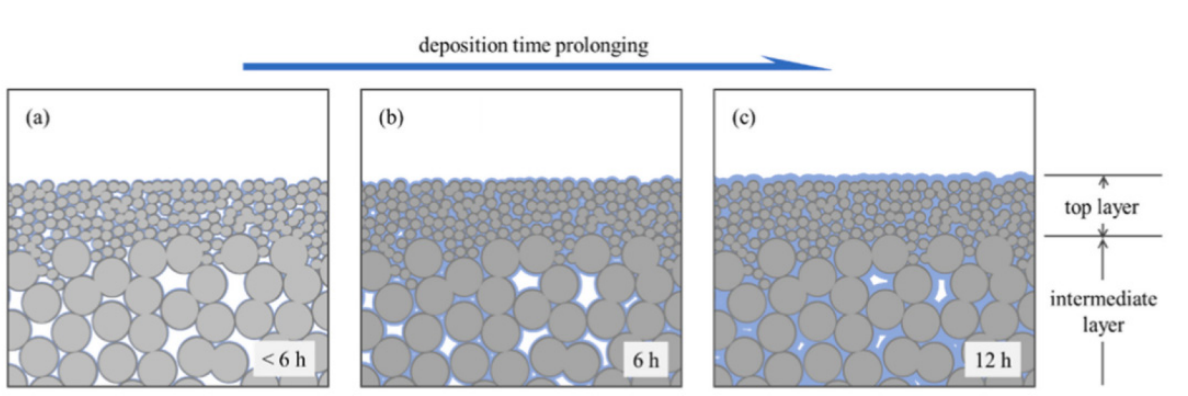
Figure 12. Ionic liquid filled the layer with deposition various times ( a ) on pore wall ( b ) top layer ( c ) top and intermediate layer [125].